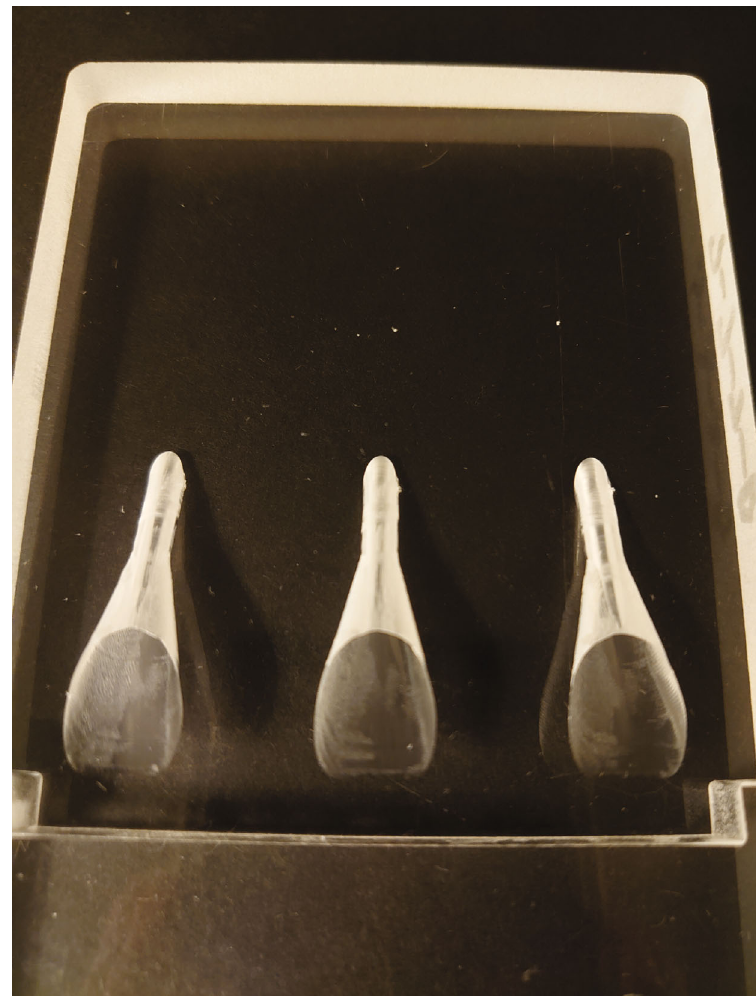
Figure 4: Machined Geometry b before testing.